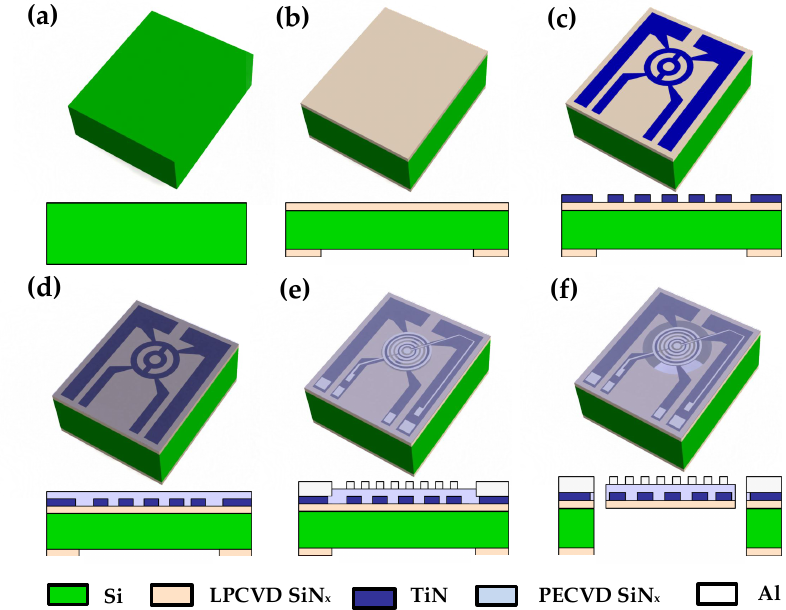
Figure 2. Fabrication process flowchart of the device ( a ) Silicon substrate. ( b ) 500 nm low-stress LPCVD silicon nitride. ( c ) Patterned 400 nm Ti/TiN microhotplate on the front side of the wafer. ( d ) 1 µ m PECVD silicon nitride isolation layer on top of the microhotplate. ( e ) Patterned 1 µ m Al/1% Si IDEs. ( f ) deep reactive ion etching (DRIE) etching of Si to obtain a suspended